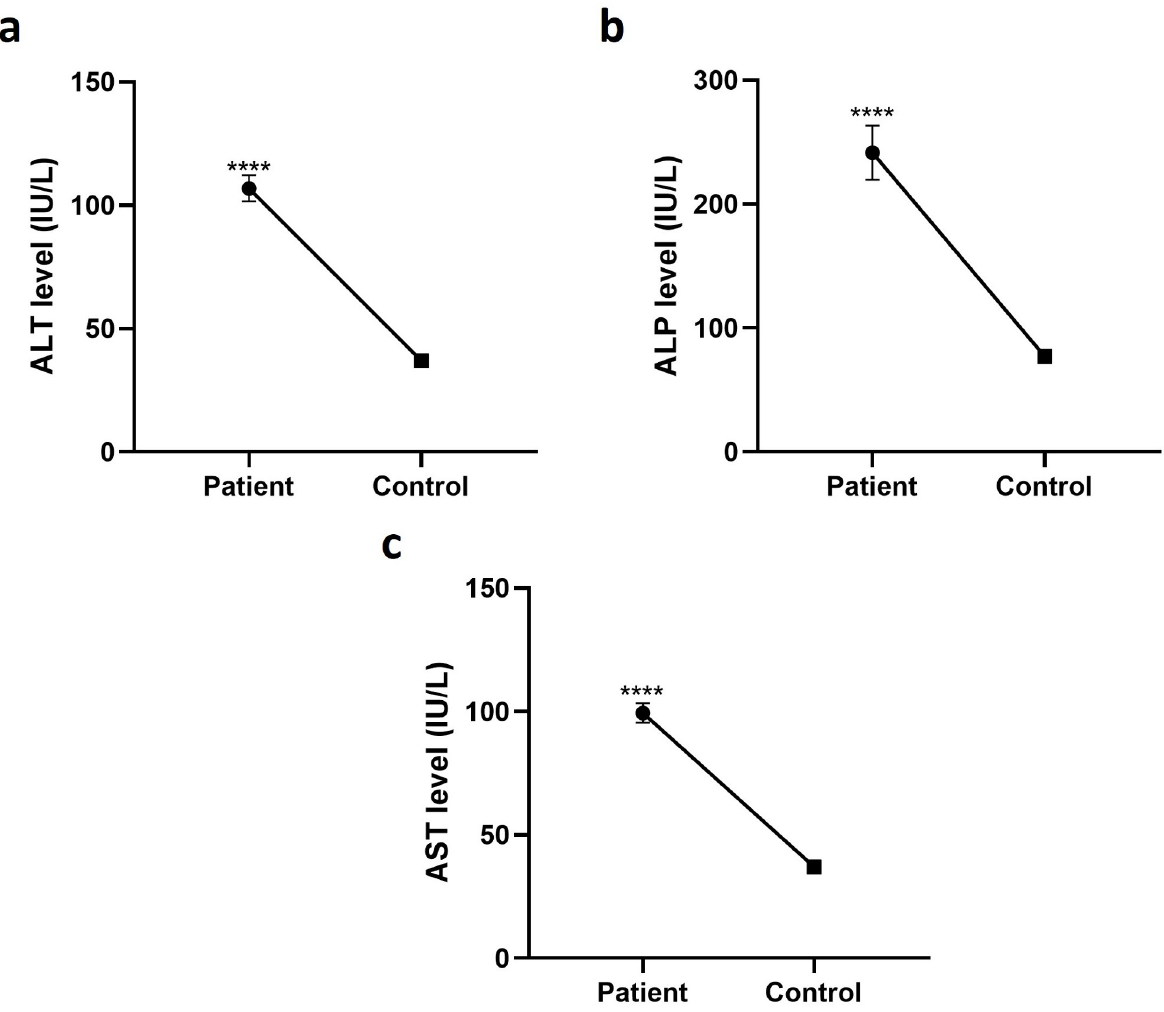
Fig 2. Comparison of ALT, ASP, and ALP levels in HCV-induced HCC patients and healthy individuals. Mean ALT, ALP, and AST levels in patients were higher than control. Data is represented as mean ± SD. ���� represents p < 0.0001. P-value below 0.05 is considered significant.